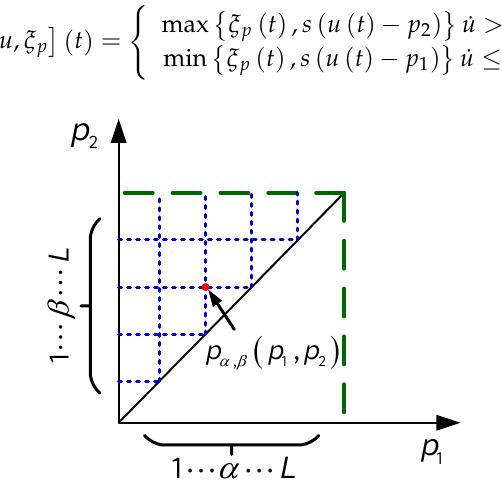
Figure 2. Discrete Preisach